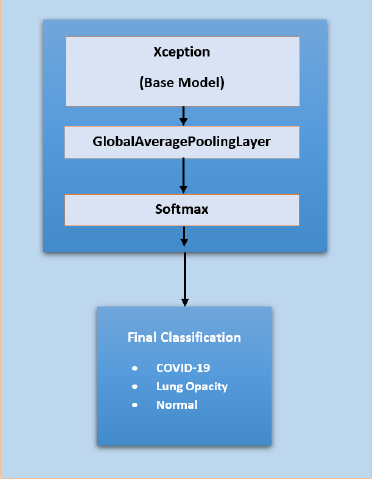
Figure 6. Xception-based